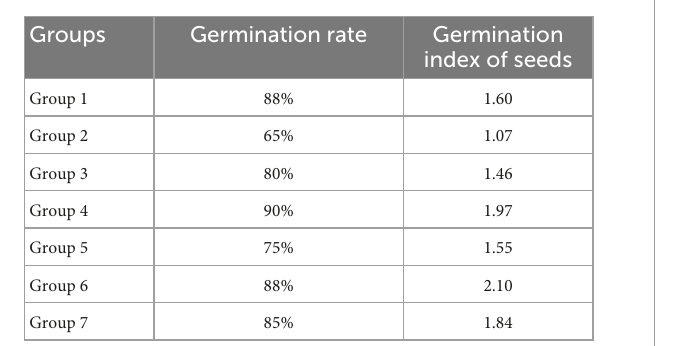
TABLE 3 Effects of additives and bacteria on germination index (GI) and germination rate of fertilizer. Groups Germination rate Germination